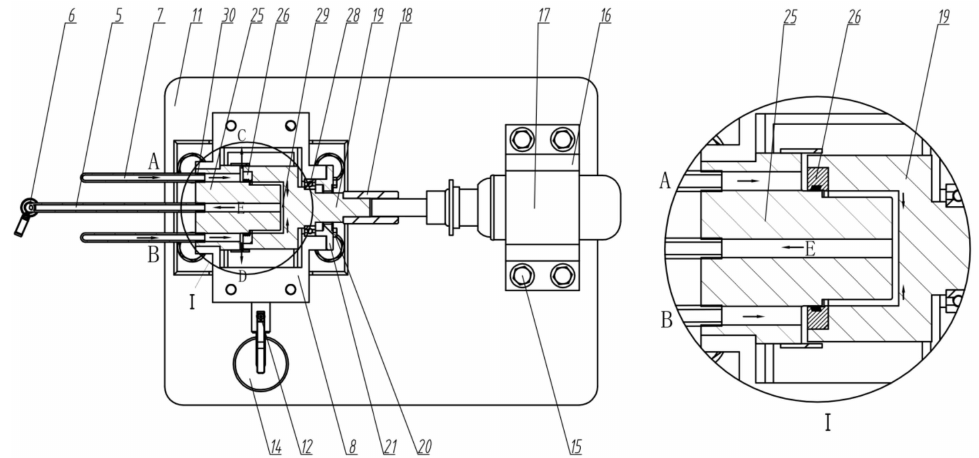
Figure 4. A sectional view of the testing device. 5. Liquid line; 6. valve; 7. liquid line; 11. bottom plate;